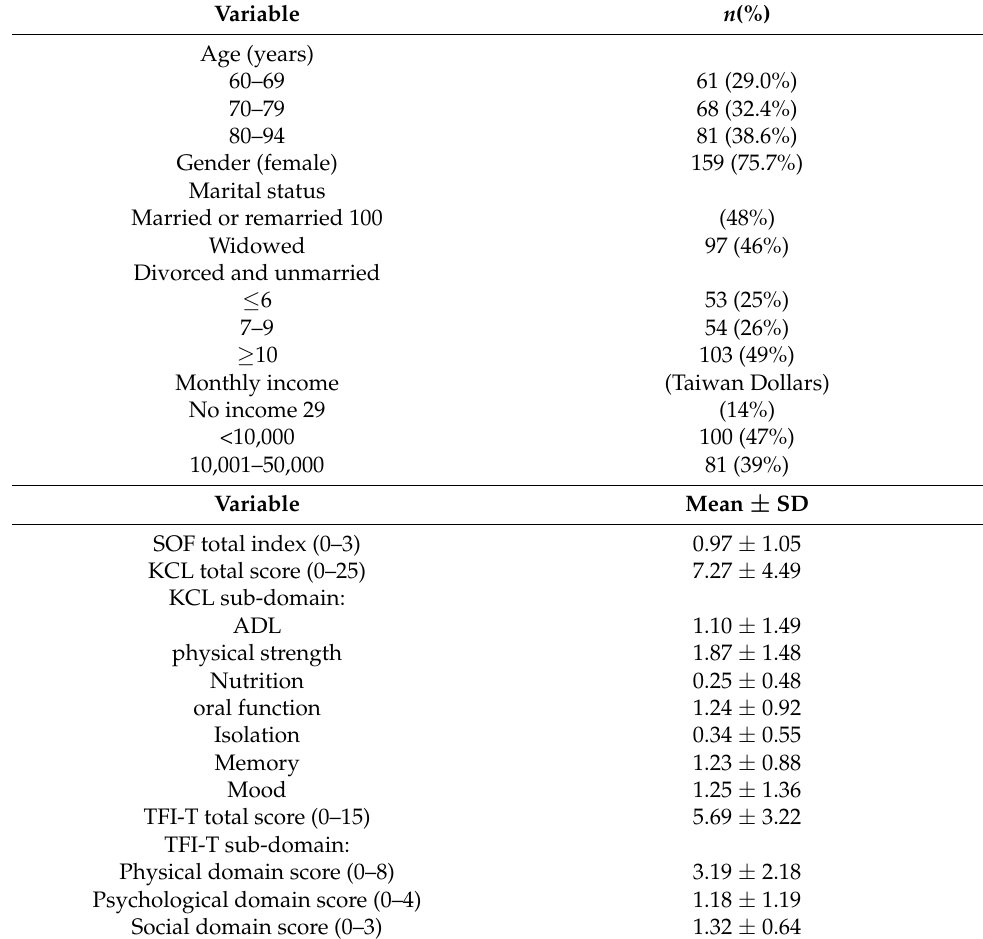
Table 1. Characteristics of participants ( N =